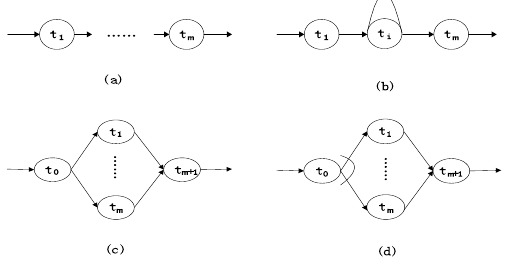
Fig. 2. Basic composite models of composite service